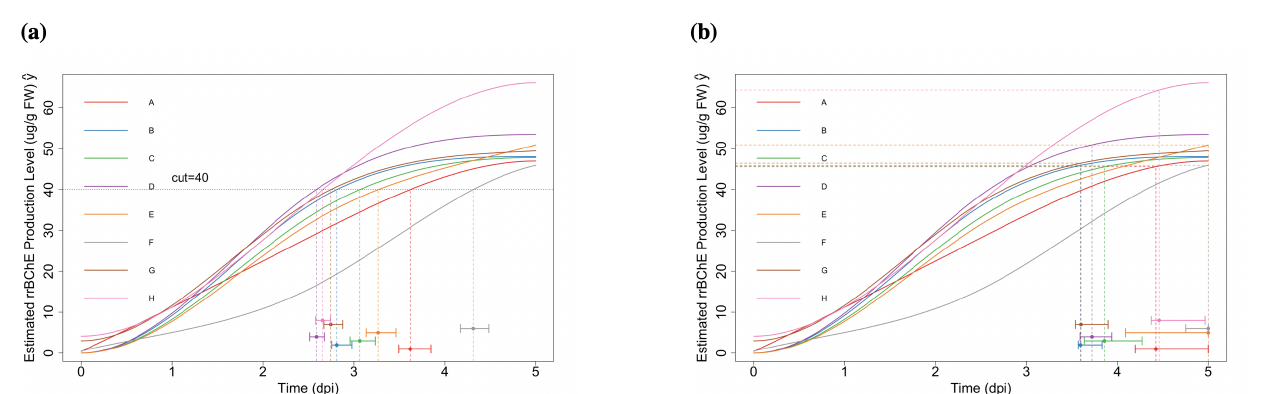
Figure 4. ( a ): Fitted curves with specified level (cut-off c = 40 ( µ g/g FW)); bootstrap confidence intervals of θ i are also shown (using t -distributed noise). ( b ): Fitted curves with specified level (˜ c = 0.1); bootstrap confidence intervals of γ i are also shown (using t -distributed noise).